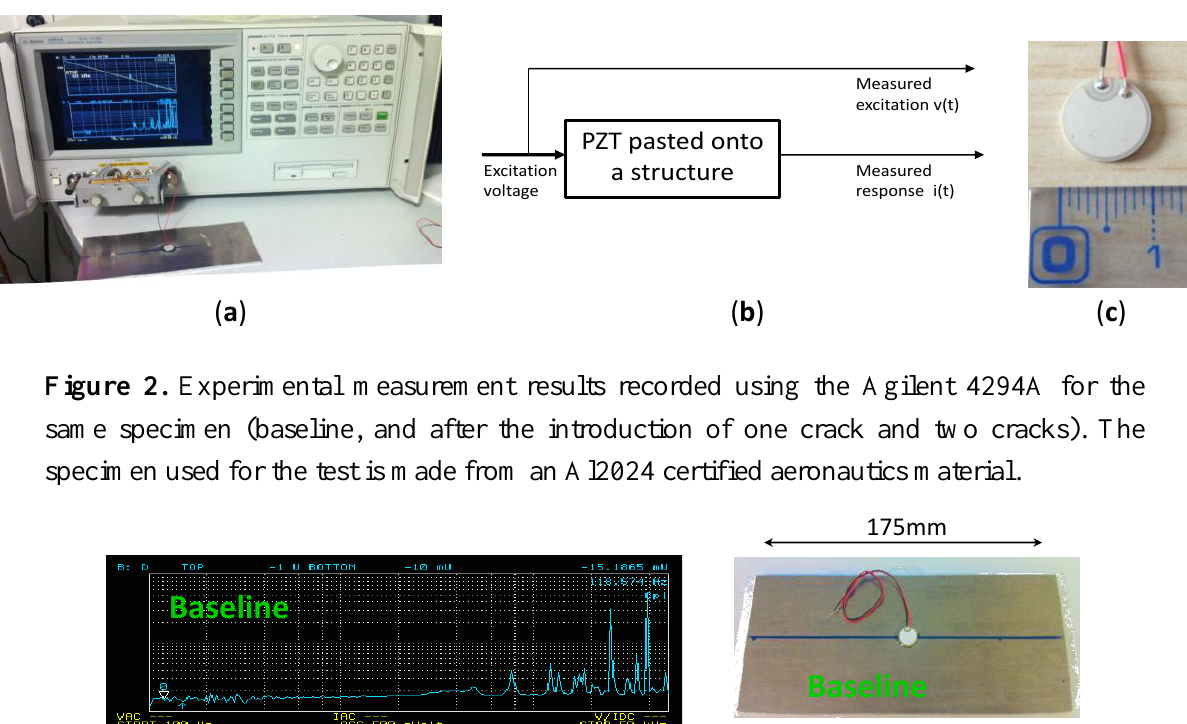
Figure 1. ( a ) Experimental measurement test bench based on an impedance analyzer Agilent 4294A. ( b ) Measurement method principle. ( c ) Photo of the piezoelectric patch, PZT 5H material, 10 mm diameter, 1 mm thickness.